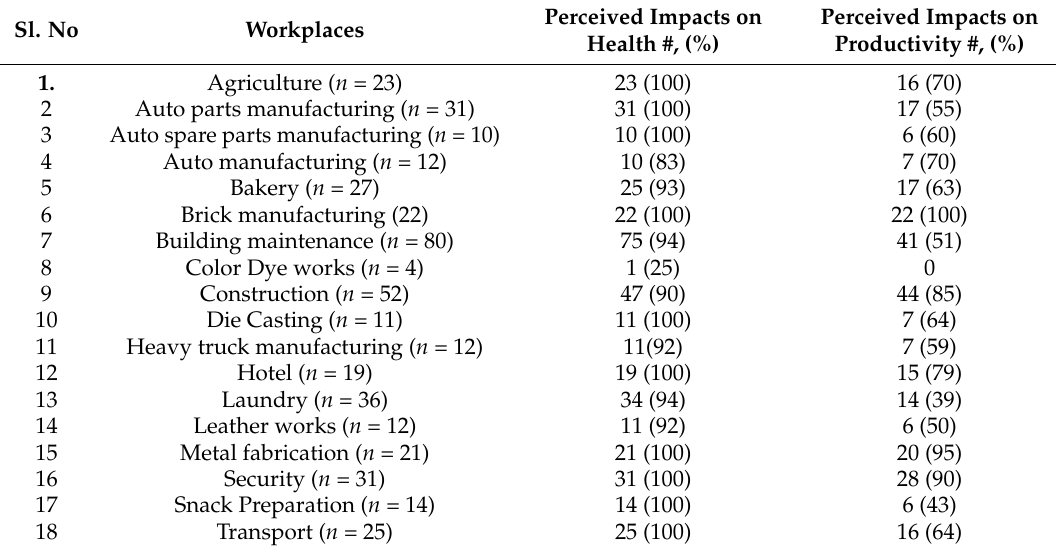
Worker perceptions of heat-related health and productivity impacts resulting from occupational heat stress in various sectors in